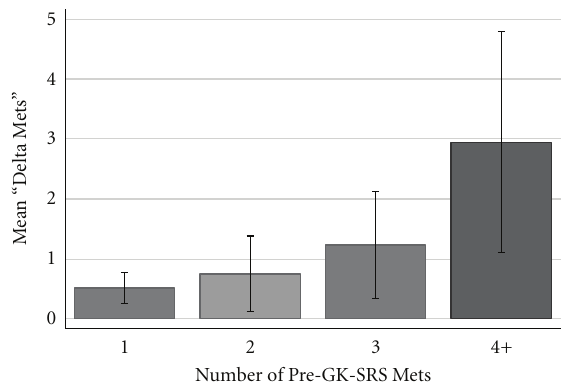
Figure 1: Bar graph demonstrating the relationship between the number of pre-GK-SRS metastases identified and the number of additional metastases (“Delta Mets”) identified at the time of GK- SRS. Error bars are